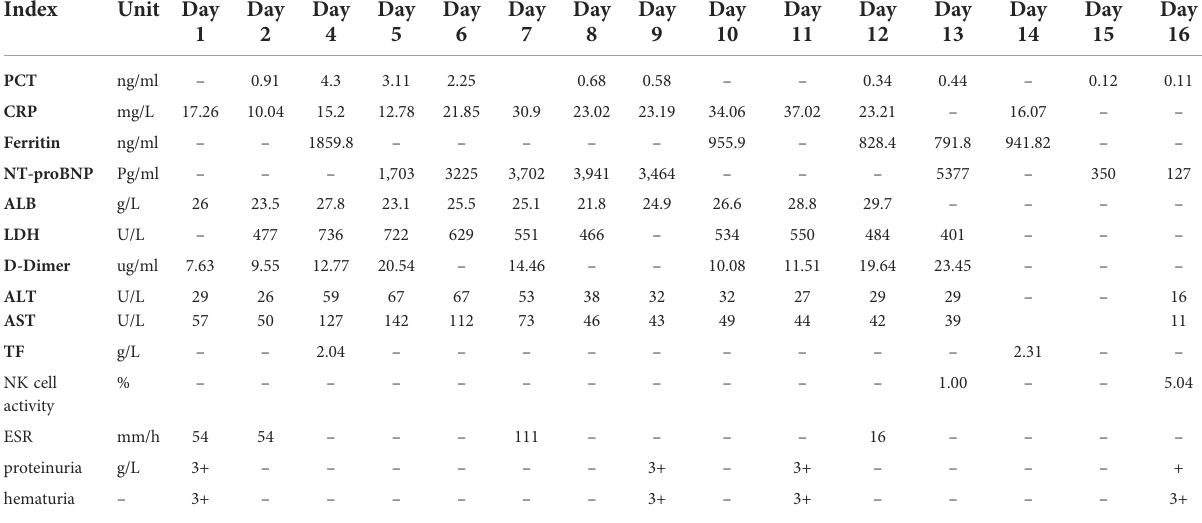
TABLE 1 Evolution of partial laboratory